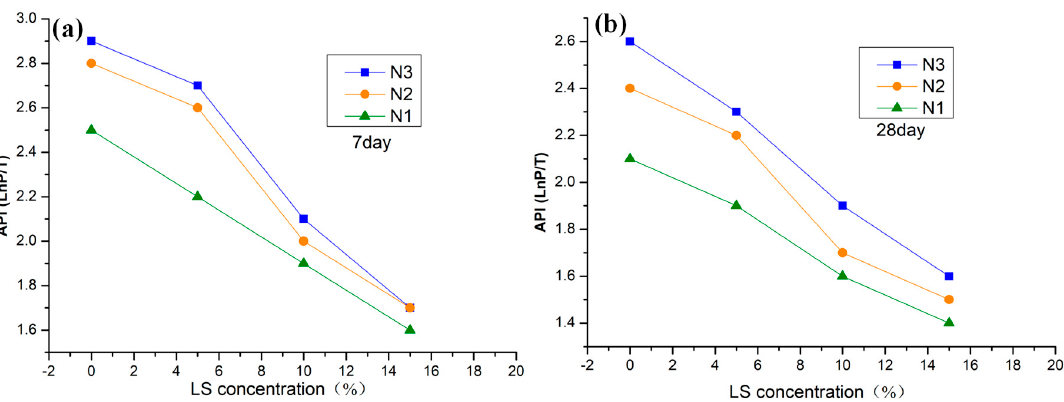
Figure 6. EffectofLSonAPIofNHL-basedmortar. ( a )Modificationafter7-daysofcuring. ( b )Modification Figure 6. Effect of LS on API of NHL-based mortar. ( a ) Modification after 7-days of curing. ( b ) after 28-days of curing. Materials 2020 , 13 , x FOR PEER REVIEW Modification after 28-days of curing.